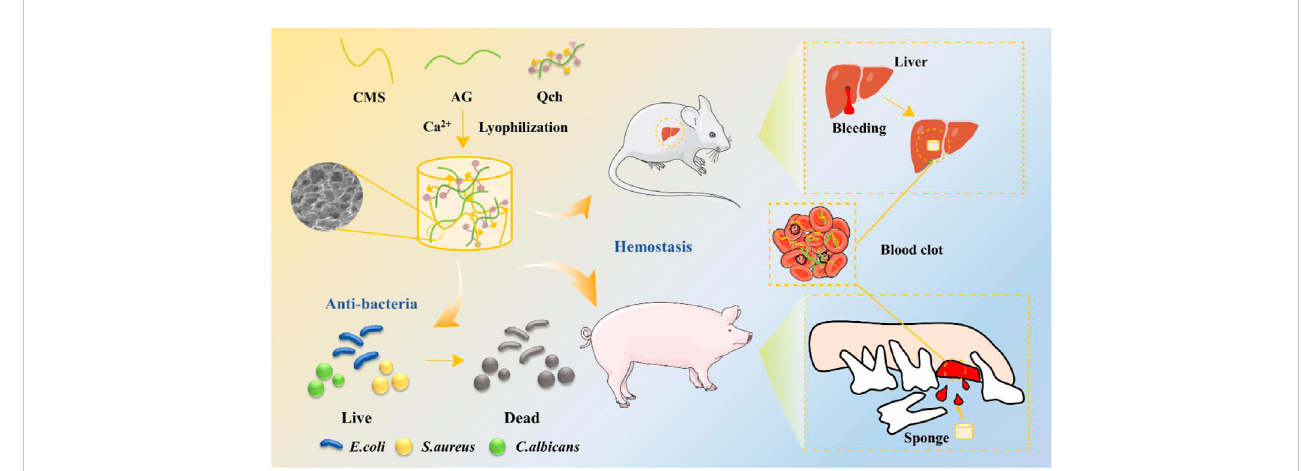
FIGURE 1 Schematic diagram of the synthesis of ACQ sponges and their application in antibacteria and